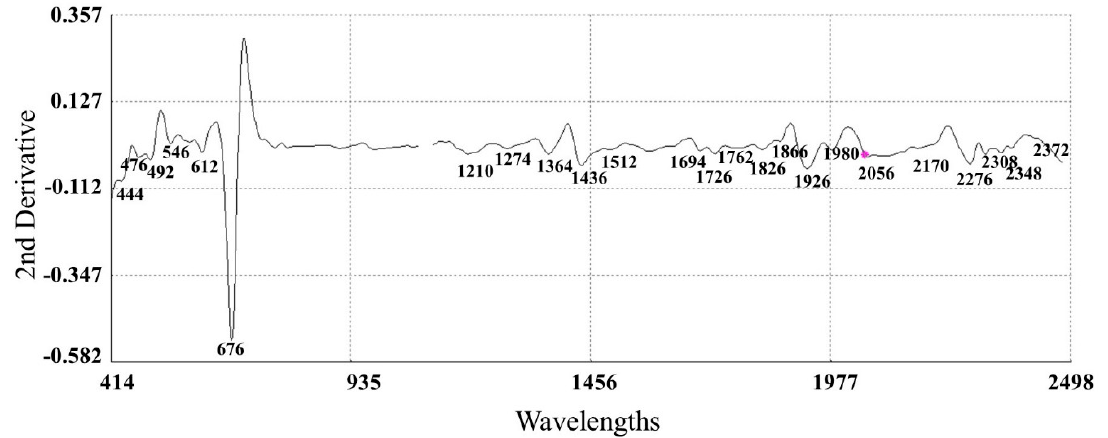
Figure 6. Second derivative spectra (2, 5, 5, 2; SNV + DT) of the raw optical data for mangetout samples in the range of 400 to 2500 nm, together with the most relevant absorption bands.